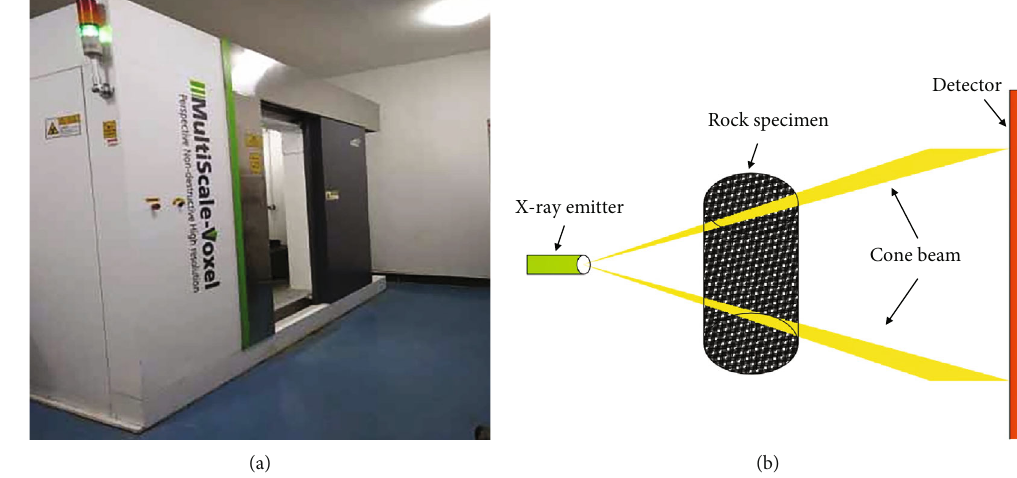
Figure 2: Microstructure test equipment: (a) CT scanner; (b) principles of CT scanning. Table 1: Deformation parameters of the specimens under di ff erent con fi ning pressures.